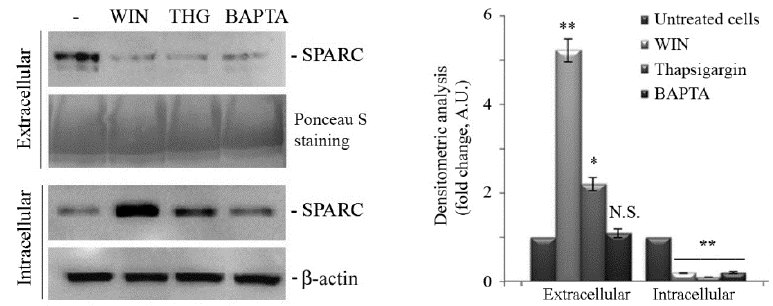
Figure 4. Effects of secretory pathway inhibitors on SPARC levels. Western blotting analysis of extracellular or intracellular level of SPARC after treatment with 5 µM WIN, 1 µM thapsigargin (THG) or 5 µM BAPTA-AM (BAPTA). Ponceau red staining or β -actin blot were reported as loading control for extracellular or intracellular protein levels, respectively. Representative blots of three independent experiments and densitometry analysis histograms are depicted. (*) p < 0.05, (**) p < 0.01 compared to the untreated sample. N.S. not significant.